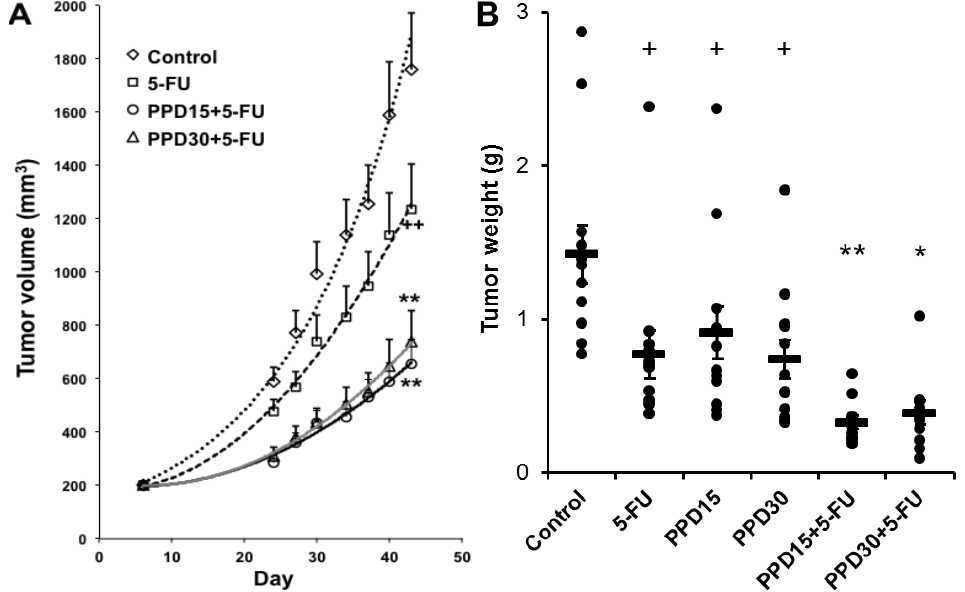
Figure 6. Protopanaxadiol (PPD) enhances the antitumor effects of 5-FU in xenografted athymic mice measured by tumor size and tumor weight. The tumor growth is monitored up to Day 43. ( A ) Changes in tumor size (in volume); ( B ) changes in tumor weight. At Day 43, tumor weights are presented as a scatter plot with mean values and error bars. 5-FU, 5-FU 30 mg/kg; PPD15, PPD 15 mg/kg; PPD30, PPD 30 mg/kg; PPD15 + 5-FU, PPD 15 mg/kg plus 5-FU 30 mg/kg; PPD30 + 5-FU, PPD 30 mg/kg plus 5-FU 30 mg/kg. n = 8/group. + p < 0.05; ++ p < 0.01 compared to the model group; * p < 0.05; ** p < 0.01, compared to the 5-FU